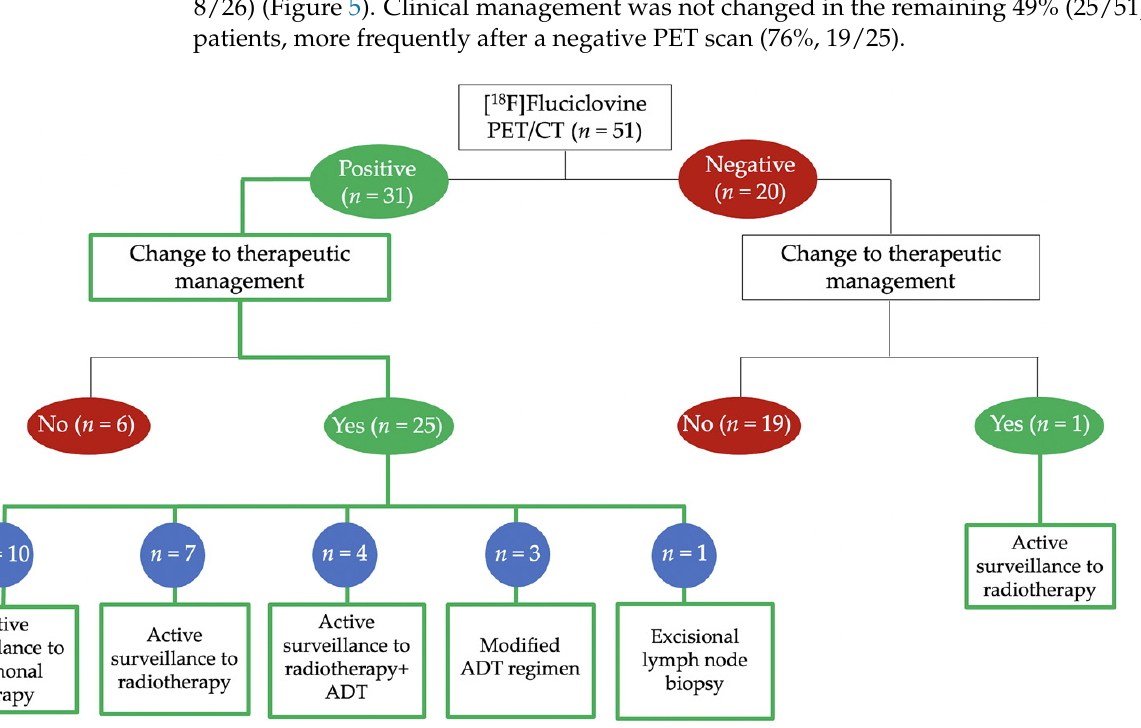
Figure 5. ( a , b ) Pre- and ( c , d ) post-therapy [ 18 F]Fluciclovine PET/CT in a 72 year-old prostate cancer patient in PSA relapse after prostatectomy (2015). Initial stage was pT2cN0 and Gleason Score 7 (4+3), classified as high EAU BCR risk group. At the time of the pre-therapy scan, PSA rose to 0.26 with a PSA doubling time of 5.13 months. [ 18 F]Fluciclovine PET/CT images (( a ): Maximum Intensity Projection; ( b ): axial fused PET/CT) showed increased amino acid metabolism in right prostatectomy bed (red arrow). Then, therapeutic strategy was changed, and patient started radiotherapy. After 4 months, post-therapy [ 18 F]Fluciclovine PET/CT images (( c ): axial fused PET/CT; ( d ): Maximum Intensity Projection) documented a metabolic response (yellow dotted arrow), confirmed by the following PSA reduction (0.05 ng/mL). 3.3. [ 18 F]Fluciclovine PET/CT Semiquantitative Analysis Out of all positive patients (66%, 38/58), RL was localized in prostate/prostatectomy bed in 71% (27/38) of patients, in lymph node in 21% (8/38), and in bone in 8% (3/38), and mean values of the relative semiquantitative parameters were SUVmax RL 4.40, T/Bratio RL 1.59, MTV RL 5.09, TLA RL 14,986.82, and SUVmean RL 2.72. The per-patient semiquantitative analysis showed no significant difference neither according to biochemical variables nor to clinical–histological ones ( p > 0.05). However, a trend towards increased SUVmax RL and SUVmean RL with higher PSA levels (especially greater than 1.0 ng/mL) was observed, as presented in Table 3. This trend was further investigated with Pearson correlation, confirming a statistically significant linear correlation between PSA level and SUVmax RL ( p = 0.006) and SUVmean RL ( p = 0.003).